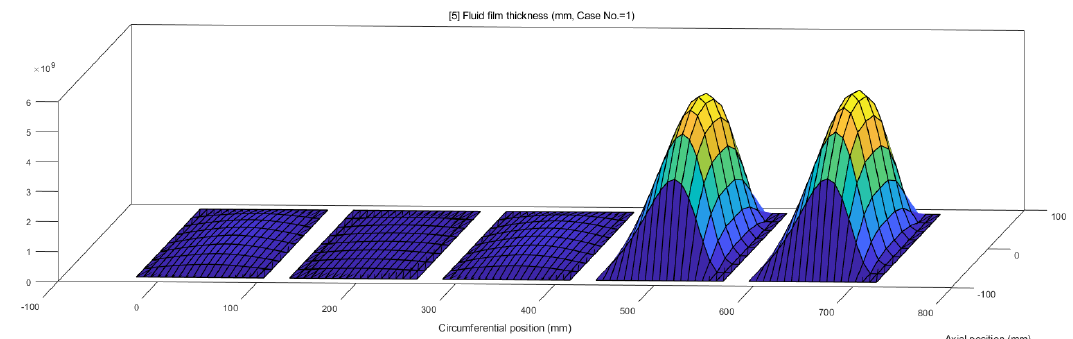
Figure 14. Pressure distribution: model no. 6 (Pa), ( T Pad = 50 °C, T Shaft = 50 °C, T Lube = 80 °C)